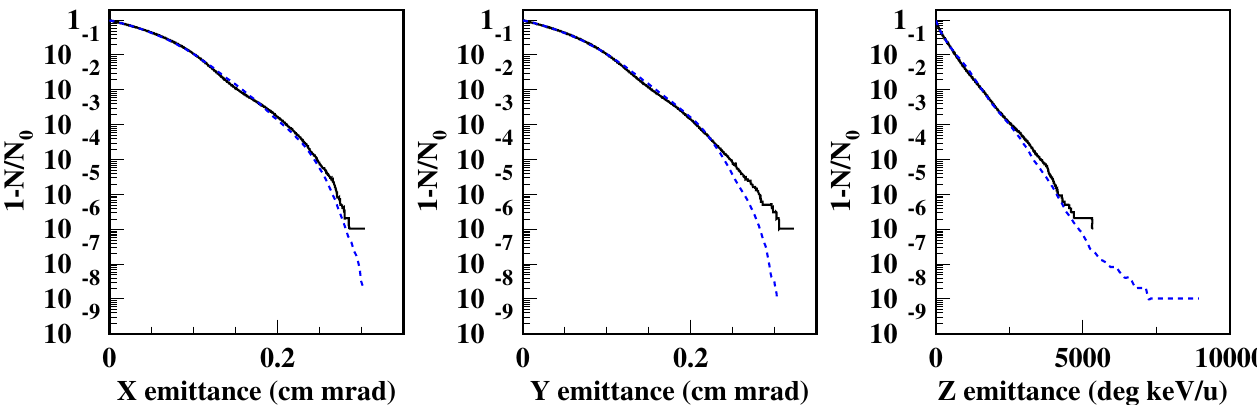
FIG. 13. (Color) Comparison of normalized emittance levels, or fractions of the beam outside a given emittance, in the phase space planes for 10 6 and 10 8 particles. The solid-black curves are for 10 6 particles, and the dashed-blue curves are from 10 8 particles.